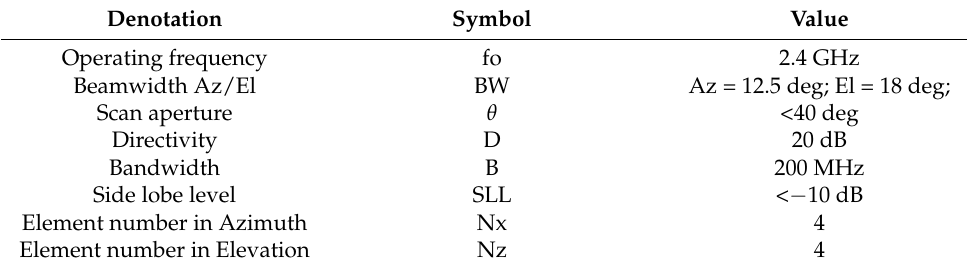
Table 1. System Design Requirement.